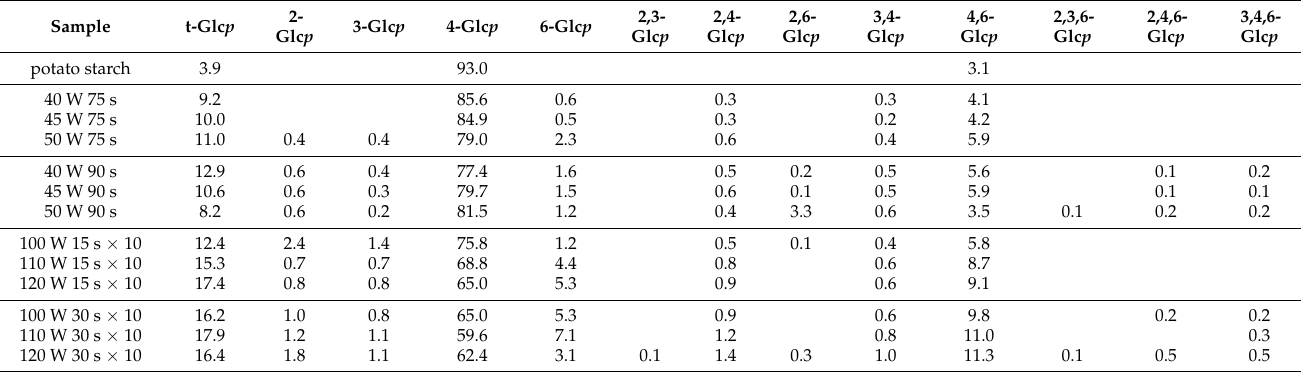
Table 4. A percentage of different glycosidic linkages of dextrins prepared under continuous and discontinuous microwave- assisted heating and native of potato starch.